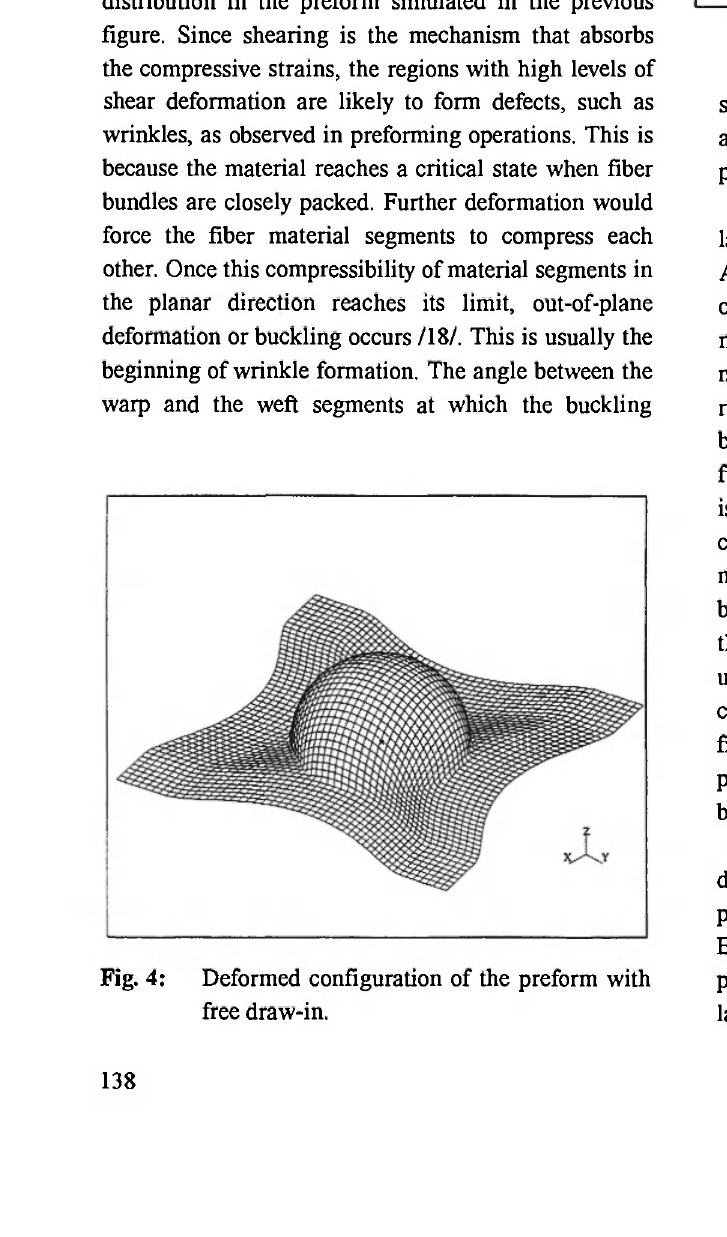
Fig. 5: Contour plot of shear angle